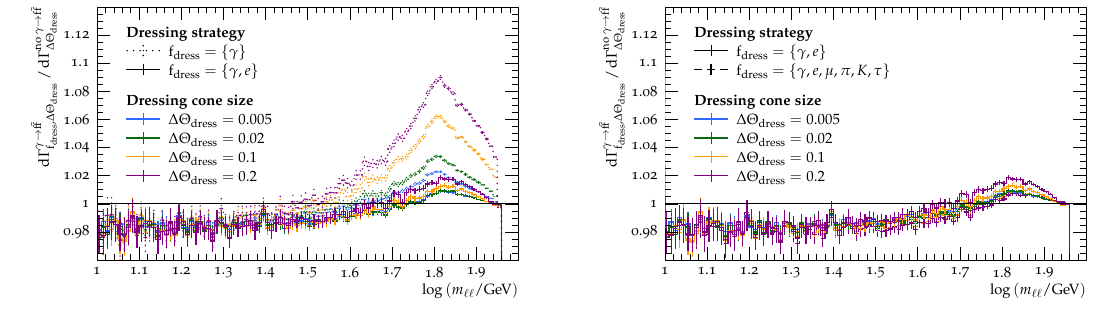
Figure 10 . This figure shows the cone size dependence of different dressing strategies. The differen- f¯f tial decay rate dΓ γ → / d log m ‘‘ has been divided by the corresponding dΓ no γ → f dress , ∆Θ dress in dependence of both the flavour set f dress included in the dressing and the dressing cone of size ∆Θ dress . The left plot shows the difference case where only photons are used in the dressing (dotted) and using both photons and secondary electrons (solid), whereas the right plot shows the difference between a dressing strategy using only photons and electrons (solid) and all secondary flavours